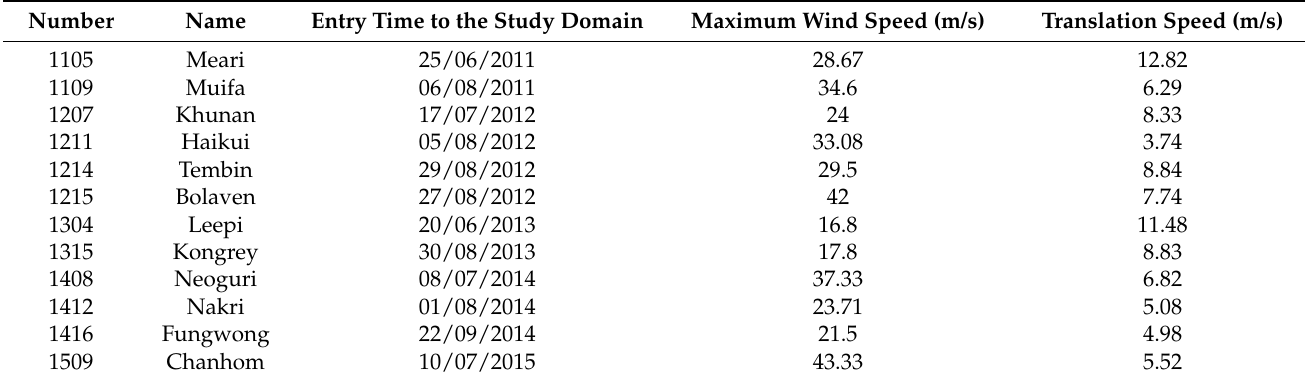
Table 1. Detailed information of the 12 typhoons. Note that the maximum wind speed and translation speed are the averaged values in the study